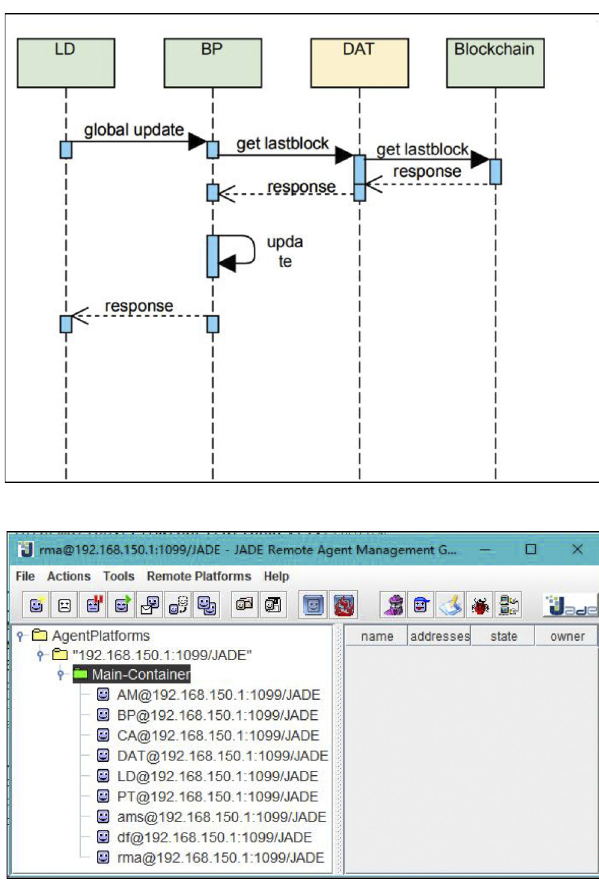
Figure 6. Smart agent in a